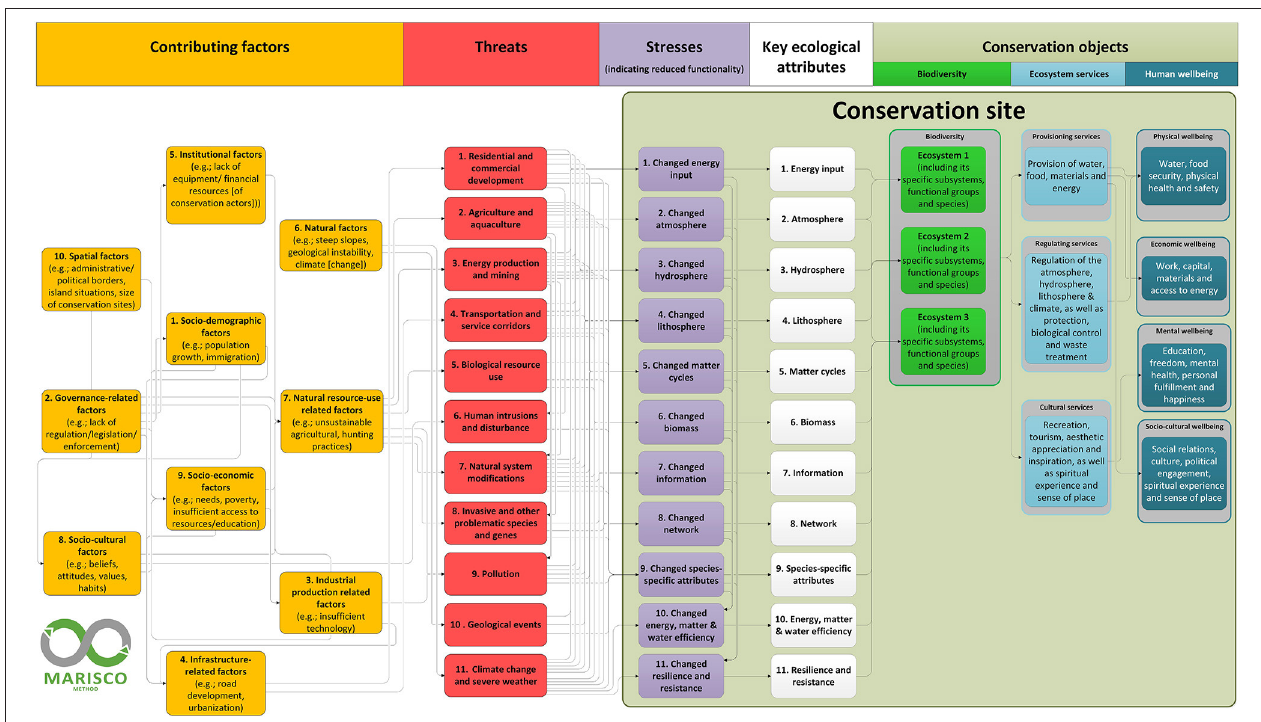
FIGURE 2 | A generic systemic knowledge map describing a hypothetical conservation site by means of eight distinct categories: contributing factors, threats, stresses, key ecological attributes, biodiversity objects, ecosystem services, and human well-being, as well as strategies.